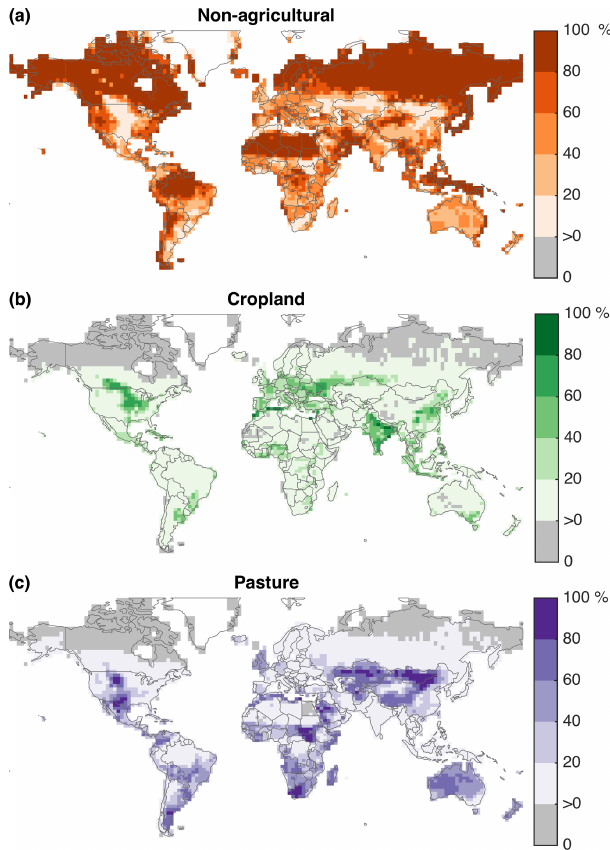
Figure 1. Mean fractional land cover of (a) non-agricultural land, (b) cropland, and (c) pasture over 2001–2009 as simulated in model runs (after Hurtt et al., 2011). Gray cells did not contain any of the indicated land cover